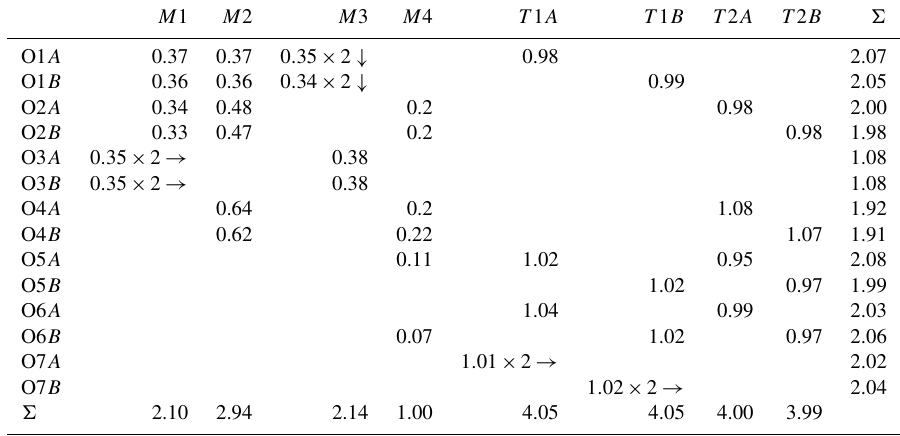
Table 8. Bond-valence analysis (v.u.) of ferro-ferri-holmquistite weighted on the refined site occupancies ∗